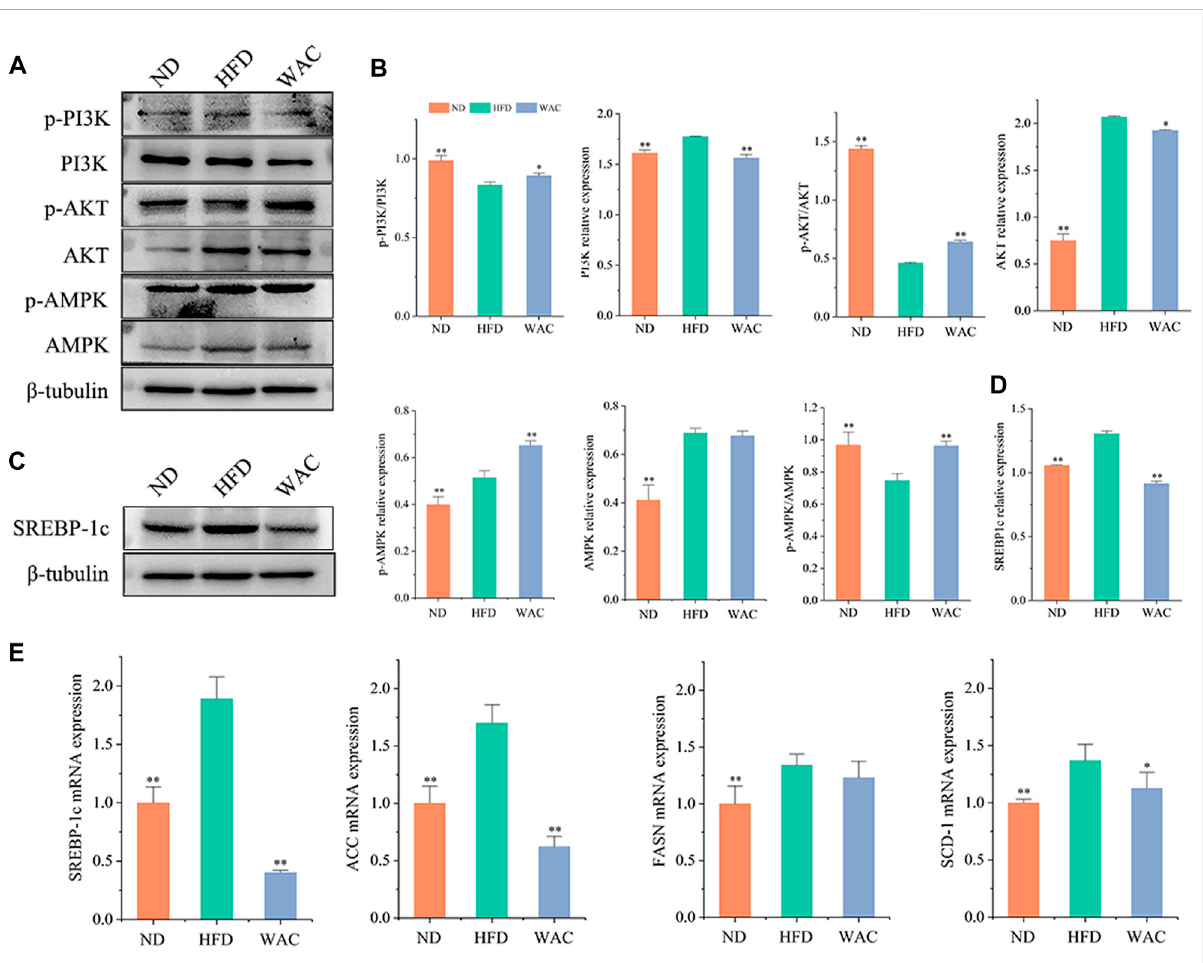
FIGURE 5 Effect of WAC on PI3K, AKT, AMPK phosphorylation and SREBP-1c protein expression in HFD-induced NAFLD mice. (A,B) Phosphorylation and total protein levels of PI3K, AKT, and AMPK in mouse liver. (C,D) Protein levels of SREBP-1c in mouse liver. (E) The mRNA levels of mouse liver FASN, ACC, SREBP-1c and SCD-1. Compared with HFD, * indicates p < 0.05 and ** indicates p <